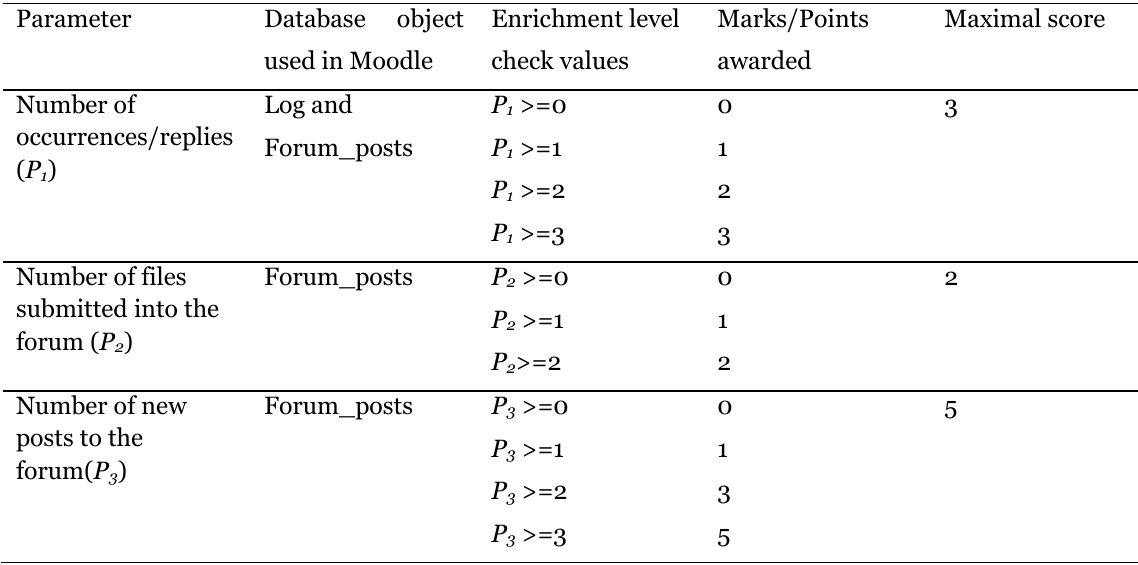
Summary of Parameters Used to Assign Marks and Assignment